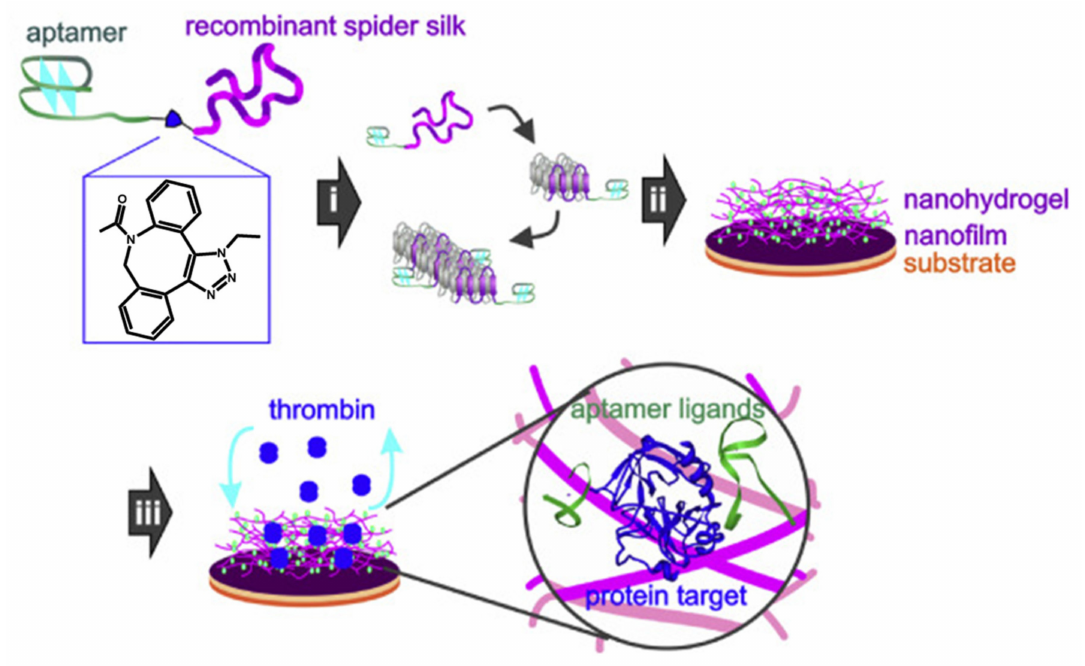
Figure 6. Scheme of the nanohydrogel assembly developed by Humenik et al., in Reference [36]. Adapted with permission from Elsevier,